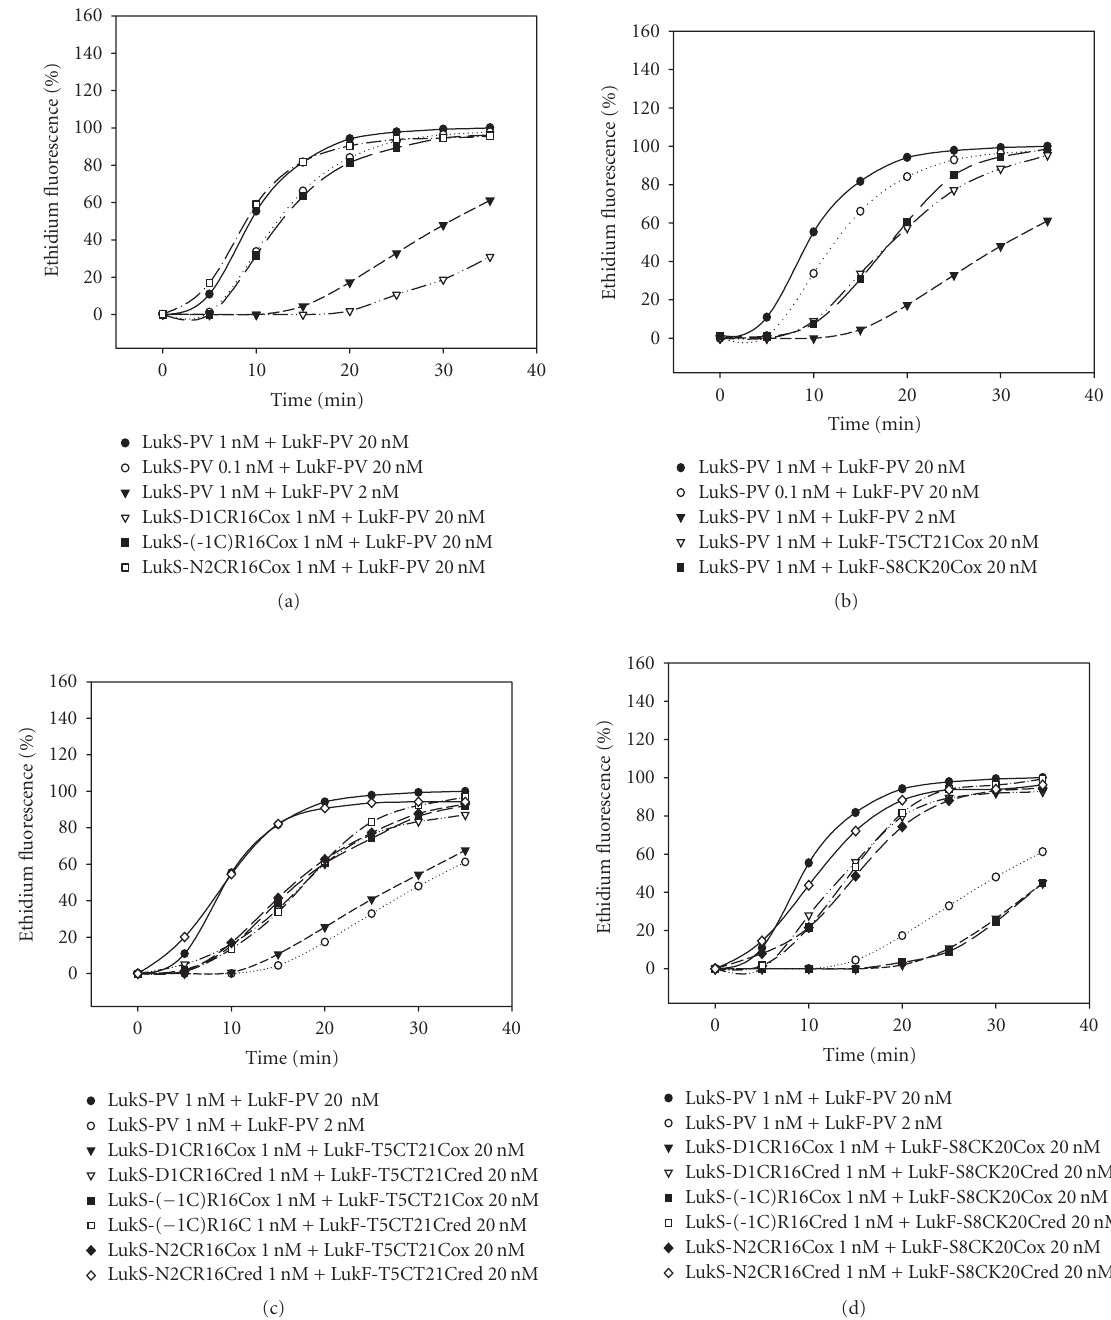
Figure 6: Flow cytometry evaluation of ethidium entry into human PMNs for di ff erent combinations of purified WT S and F proteins and their oxidized or reduced double mutants. (a) Oxidized LukS-PV mutants were first tested with WT LukF-PV. (b) Oxidized LukF-PV mutants were tested with WT LukS-PV. (c) Oxidized or reduced LukS-PV double mutants were tested with LukF-PV S8C-K20C. (d) Oxidized or reduced LukS-PV double mutants were tested with LukF-PV